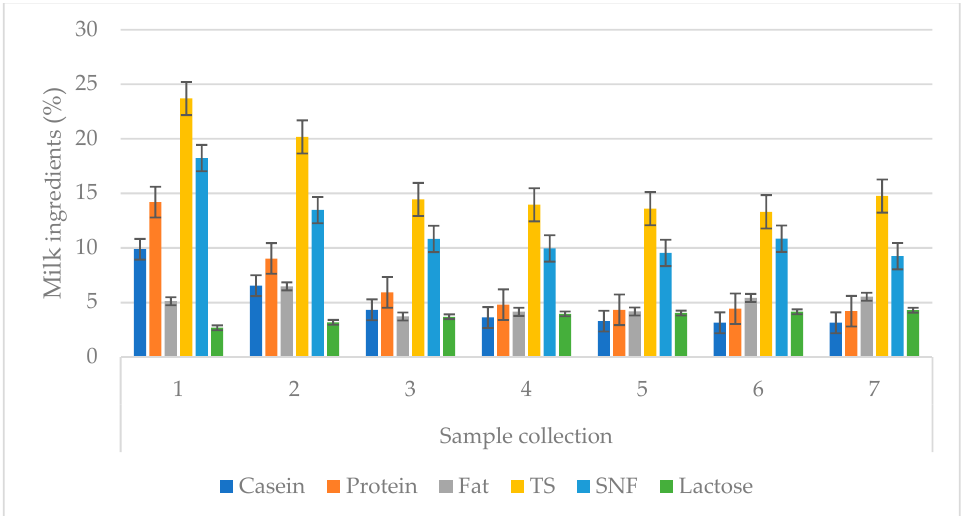
Figure 1. Changes in the chemical composition of colostrum over subsequent colostrum samples. Data are presented as least squares means along with their standard errors of mean. Statistical differences between collection groups at p ≤ 0.01. TS—total solid; SNF—solid non-fat.